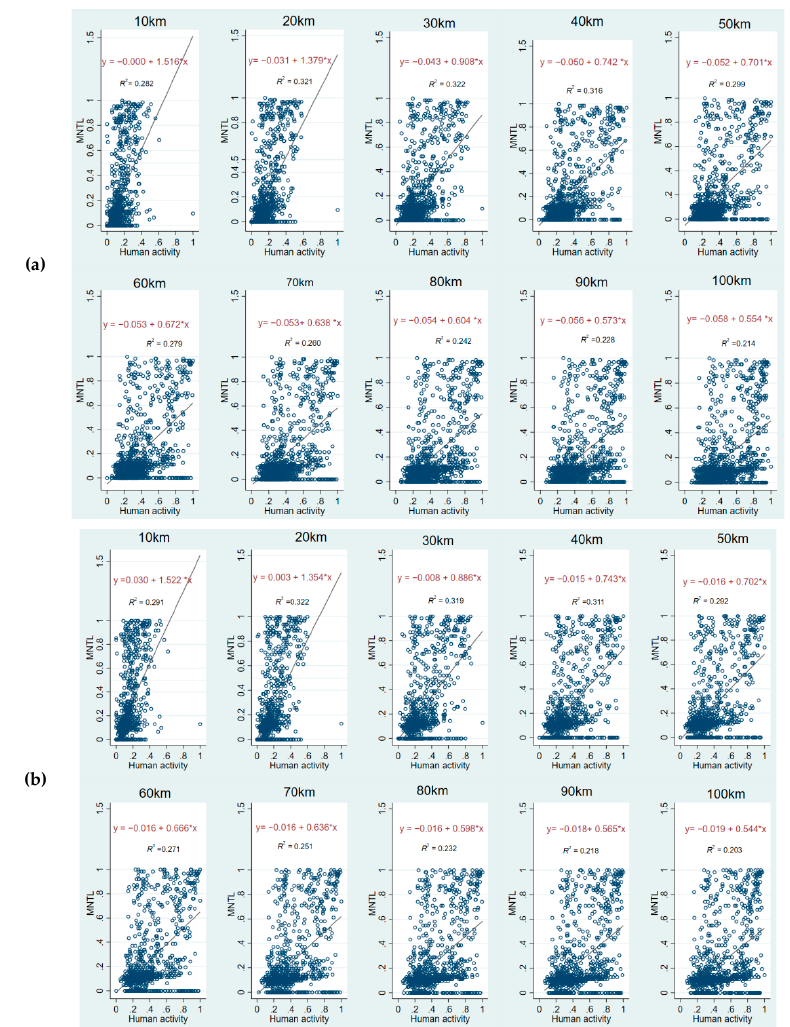
Figure 5. Scatter diagram of MNTL in PAs and human activity at different distances. ( a ) Fitting results in 2013; ( b ) Fitting results in 2017.